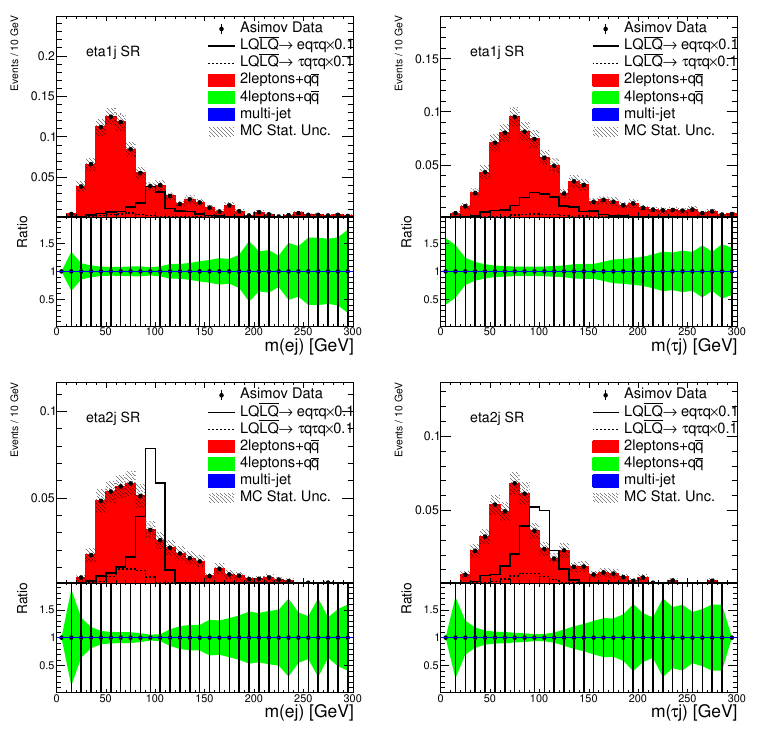
Figure 4 . The distribution of the invariant mass of a lepton candidate and a jet candidate in the signal region “eta1j” (top) and “eta2j” (bottom). The left one is m ( ej ) and the right one is m ( τj ) . The black points in the upper pads show the asimov data which is just the sum of all background events with uncertainties completely suppressed for better illustration. The ratio of the asimov data and the total background is shown in the lower pads, where the error bars on the black points represent the expected data uncertainty while the green bands represent the total MC statistical